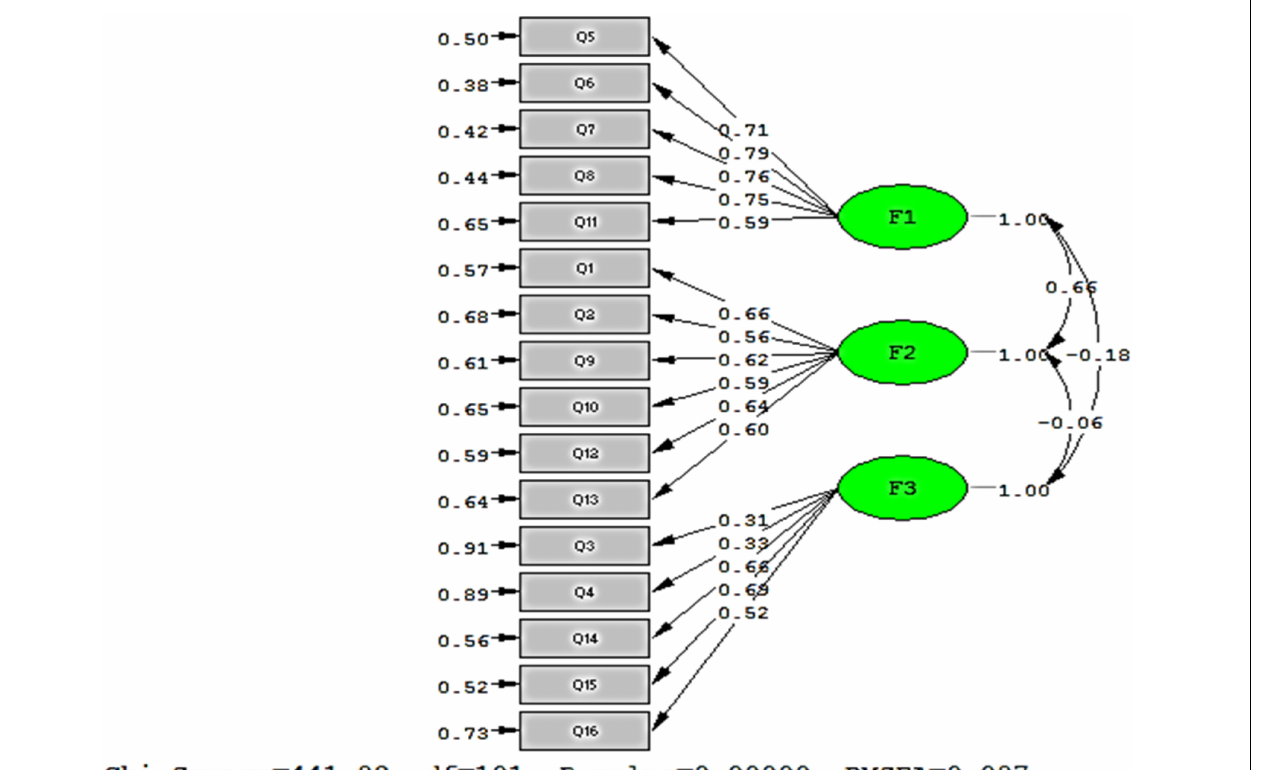
FIGURE 1 | The final structure of the